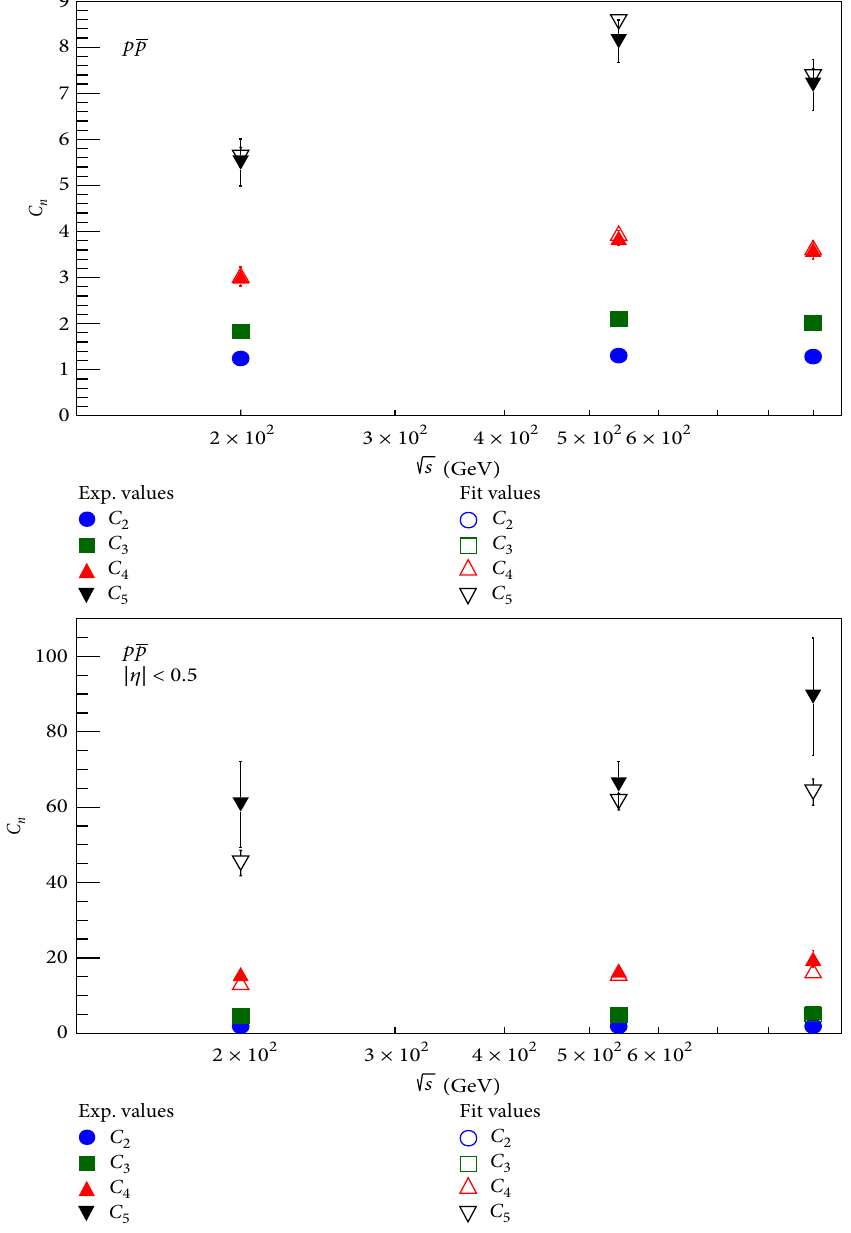
Figure 7: Normalized moments C different energies, in full phase space and pseudo-rapidity bin, | η | <